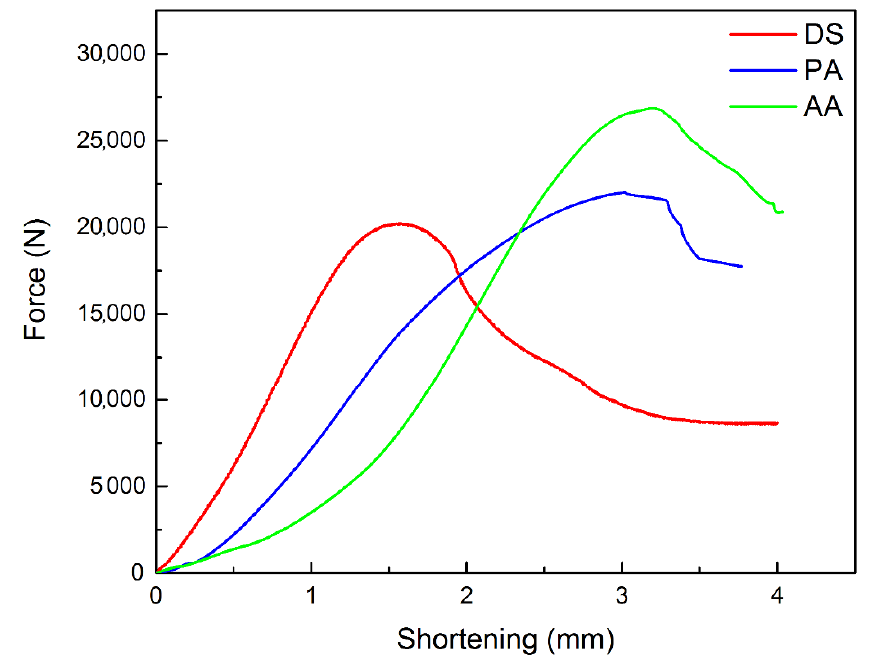
Figure 8. Compression load–displacement graphs (F c –D c ) for the three species at 6 months.